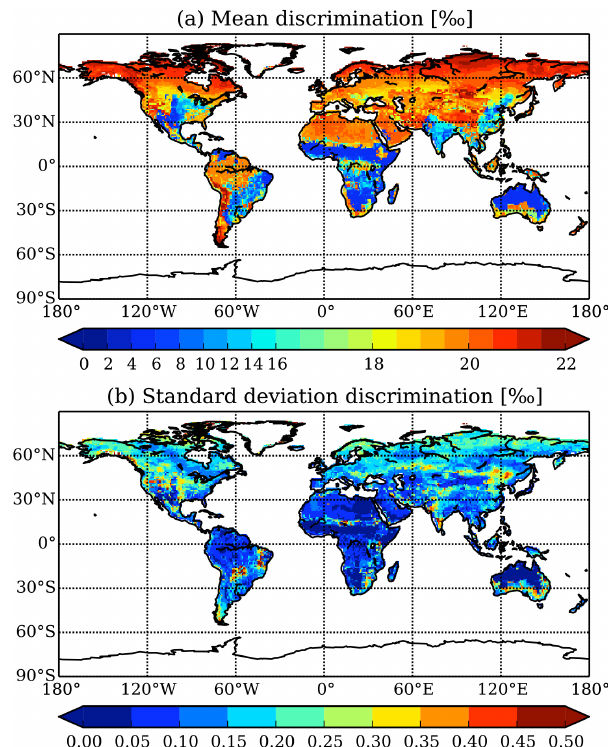
Figure 2. SiBCASA-ISOVAR assimilation-weighted annual plant discrimination (a) , from a 13yr period (1997–2009), and the year- to-year variability (1 σ ) of the annual discrimination values deter- mined from the same 13yr period (b) . Differences in C 3 and C 4 metabolic pathways give the clear spatial contrast in the annual mean discrimination. Variations in grid-cell-average discrimination are largely driven by RH, precipitation, and soil moisture condi- tions. The largest standard deviations are found in parts of South America and Africa in mixed C 3 / C 4 grid cells, where independent changes in C 3 or C 4 GPP can change grid cell mean discrimination value significantly. Note that the color scale in (a) is